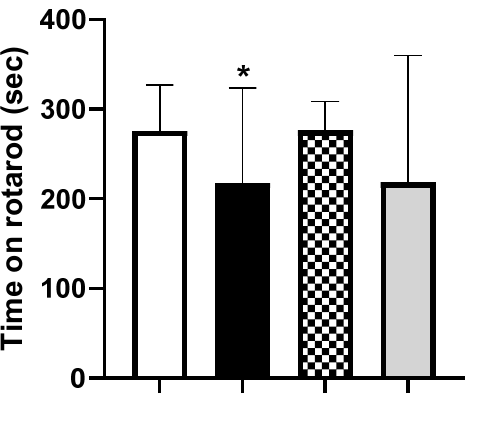
Figure 4. Effect of CA(2-Me)-Am on neuromuscular coordination. The asterisks above bars indicate significant differences in number of falls per minute for each experimental group versus the control at * p < 0.05. Statistical analysis was performed by one-way analysis of variance (ANOVA) followed by Dunnett’s post hoc comparison test.